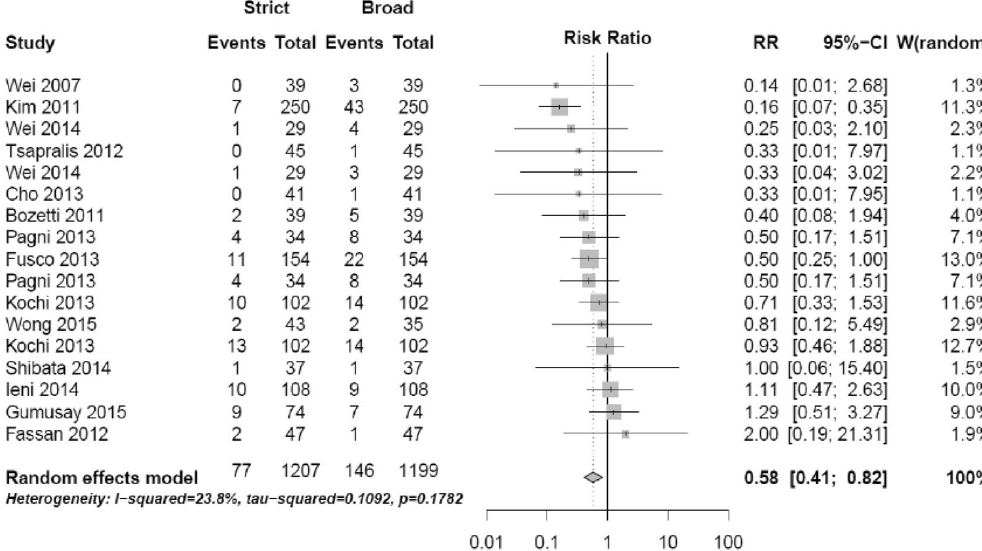
Figure 2. Random-effect pair-wise meta-analysis of total HER2 status discordance of strict vs. broad methods of HER2